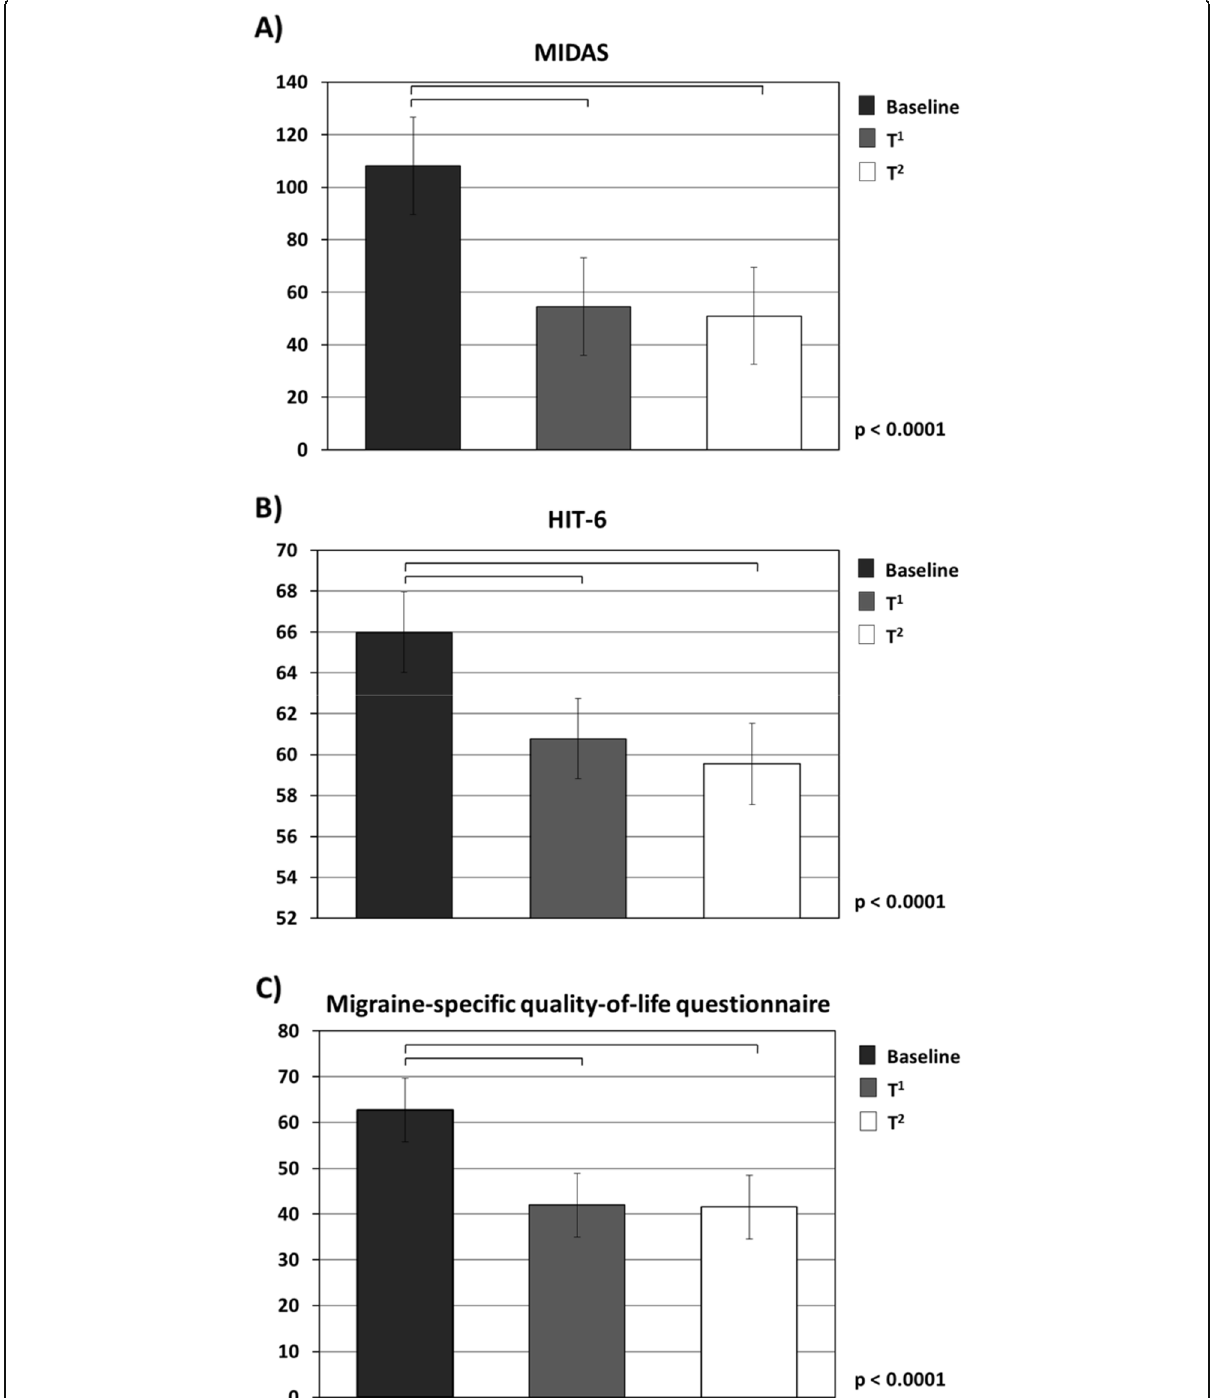
Fig. 3 Migraine-related disability and impact on daily living scores at baseline (T 0 ), and at the end of the third (T 1 ) and of the sixth month (T 2 ) of erenumab administration. HIT: headache impact test; MIDAS: migraine-related